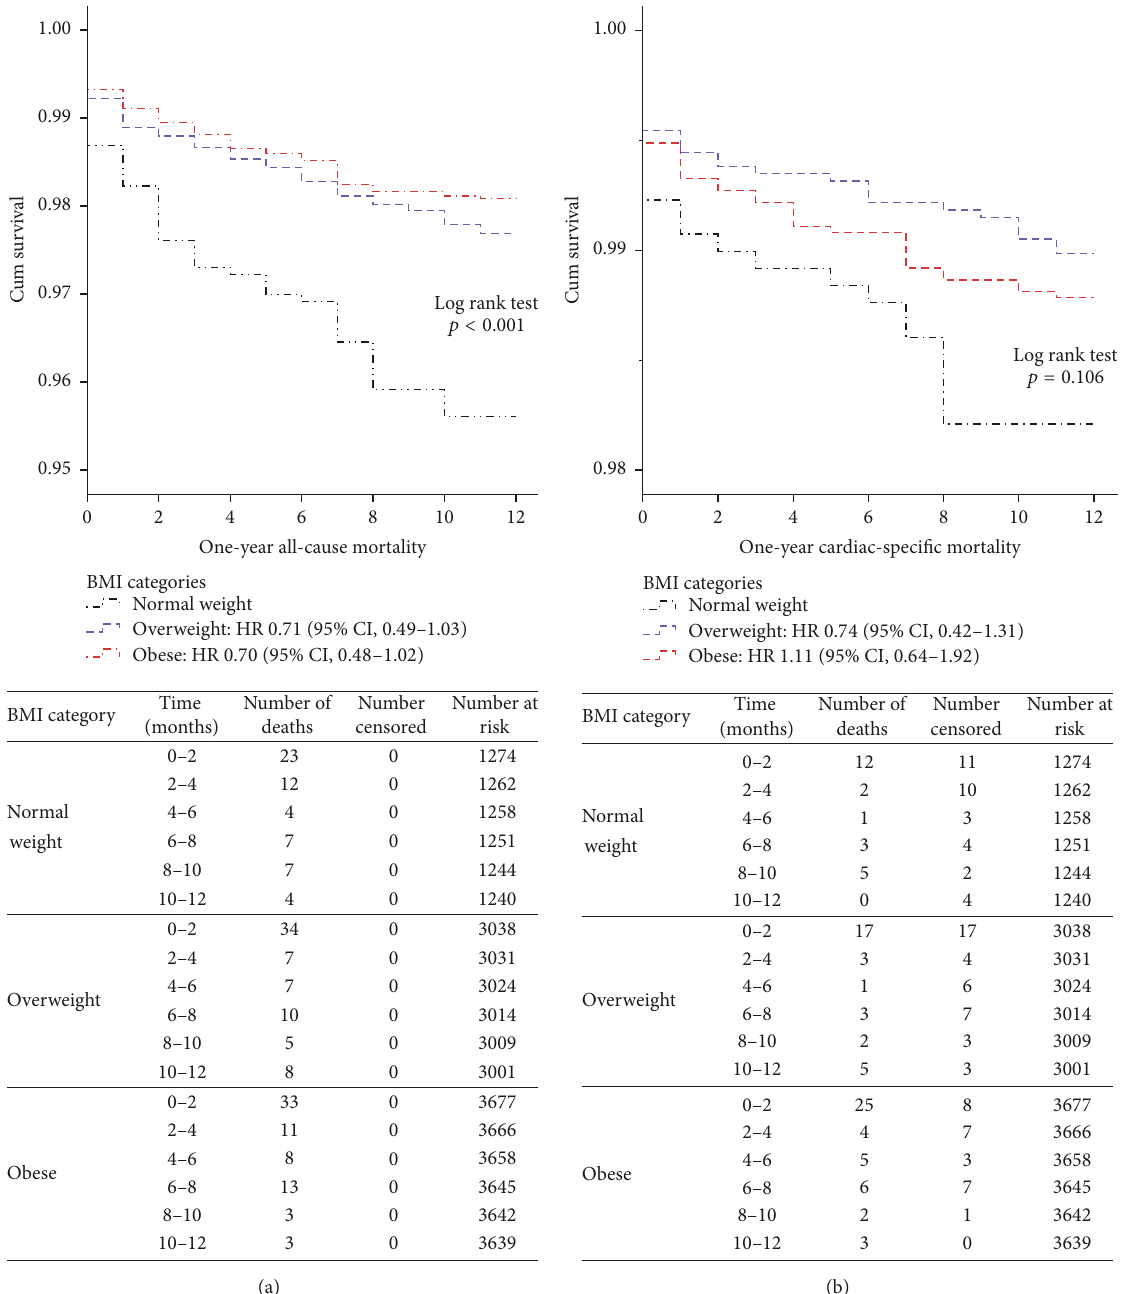
patients were overweight and obese. In the current study, obese patients were significantly younger (i.e., 3.7 years) than their nonobese counterparts and presented with less severe CAD based on DJSs despite having a higher prevalence of HTN, hyperlipidemia, and diabetes. Normal weight patients were older, had PVD, and had a history of renal insufficiency or were on